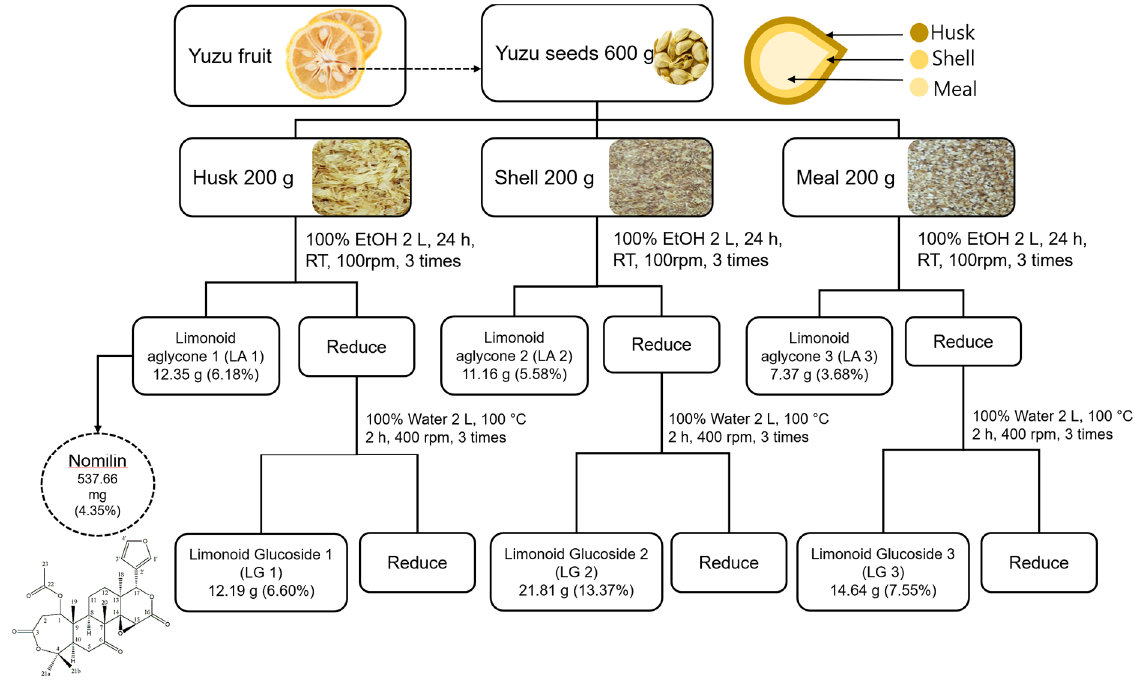
Figure 1. Schematic diagram showing the preparation of yuzu seed extracts. Percentages in paren- thesis mean extraction yields based on the initial quantity of yuzu seeds. LA: limonoid aglycone, LG: limonoid glucoside.